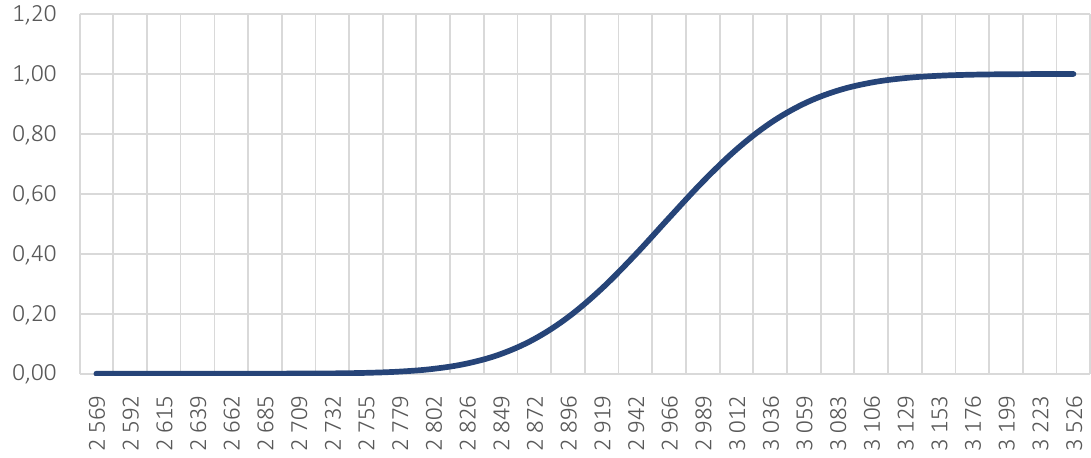
Figure 2. Cumulative distribution function of generation Z Table 3. Cumulative distribution function of generation Z –